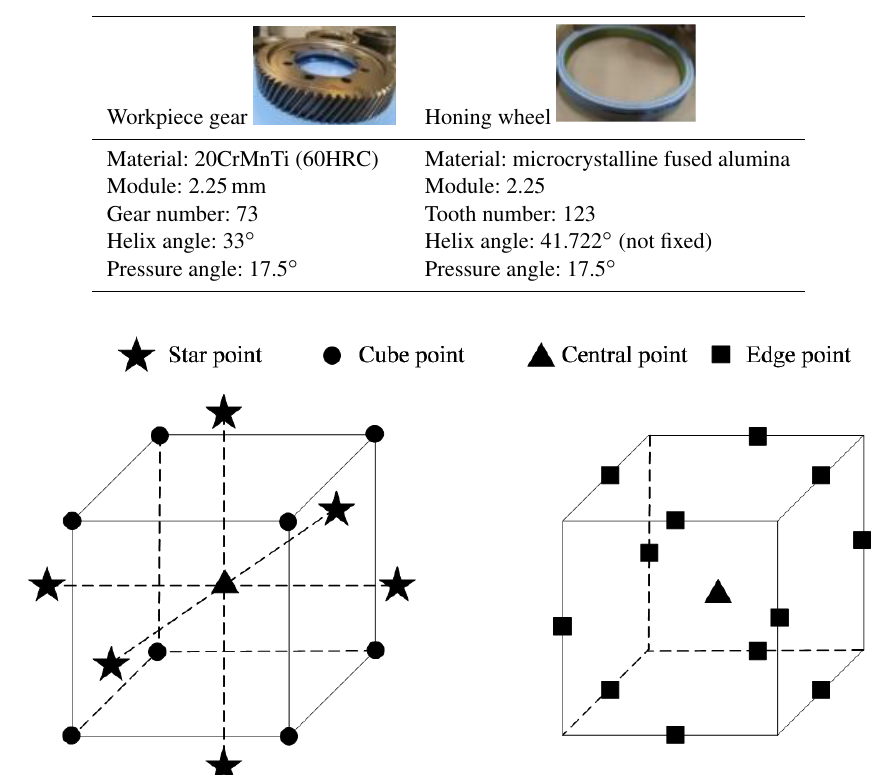
Table 2. Basic parameters of workpiece gear and honing wheel.